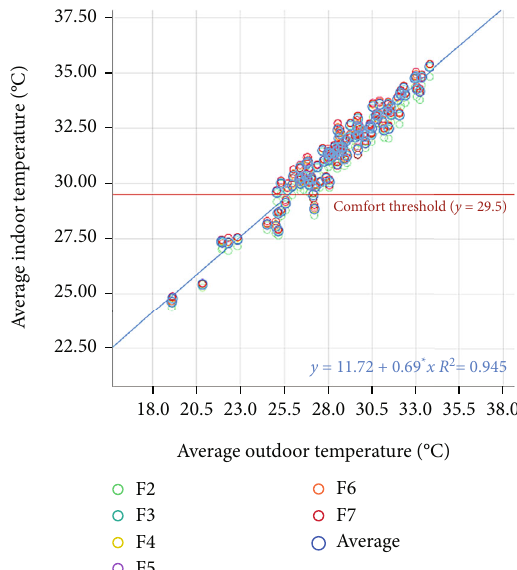
Figure 8: Daily average indoor temperatures in relation to average outdoor temperatures.